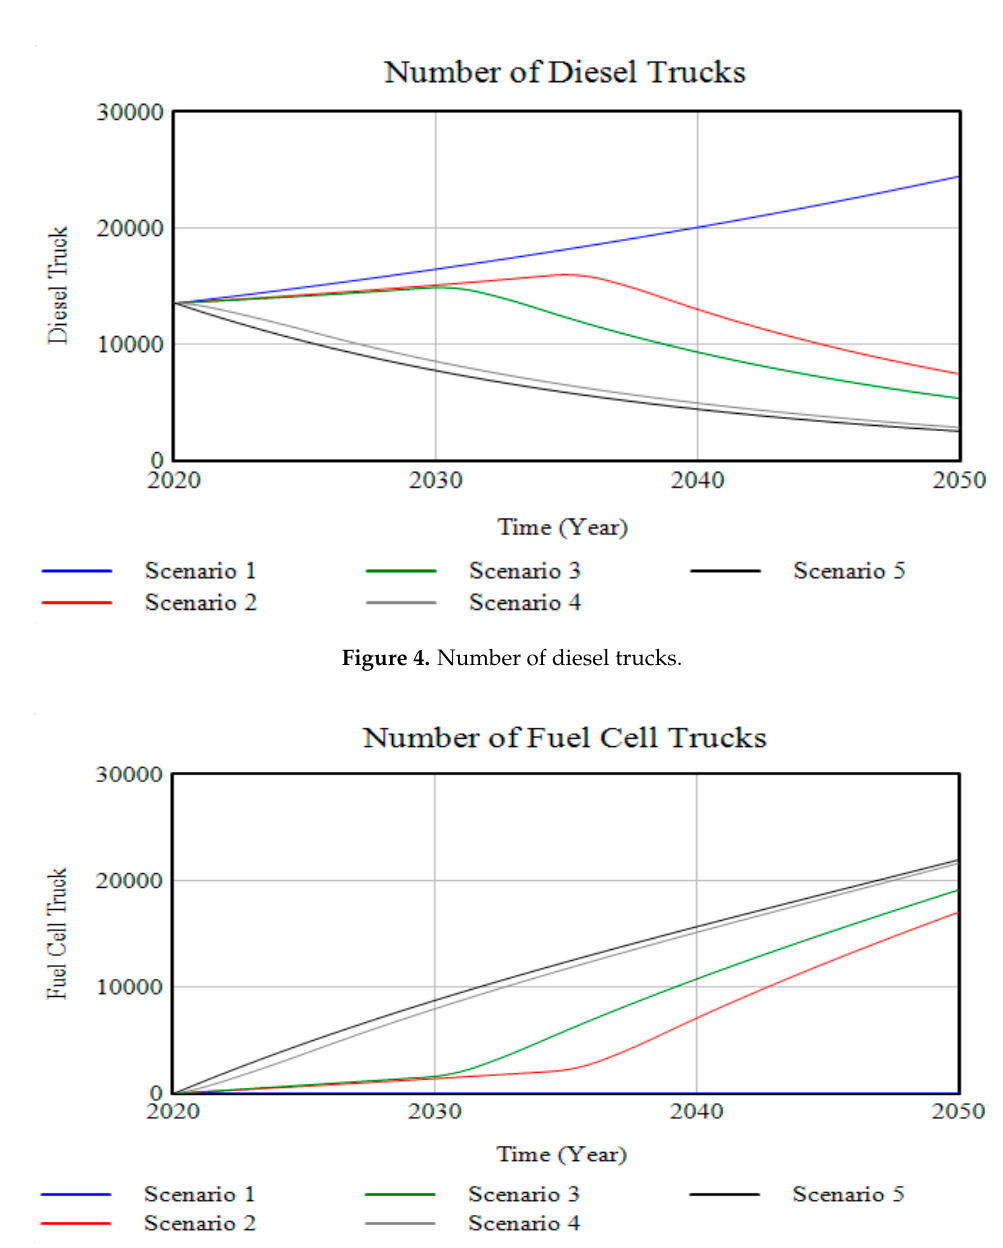
Figure 5. Number of fuel cell trucks.